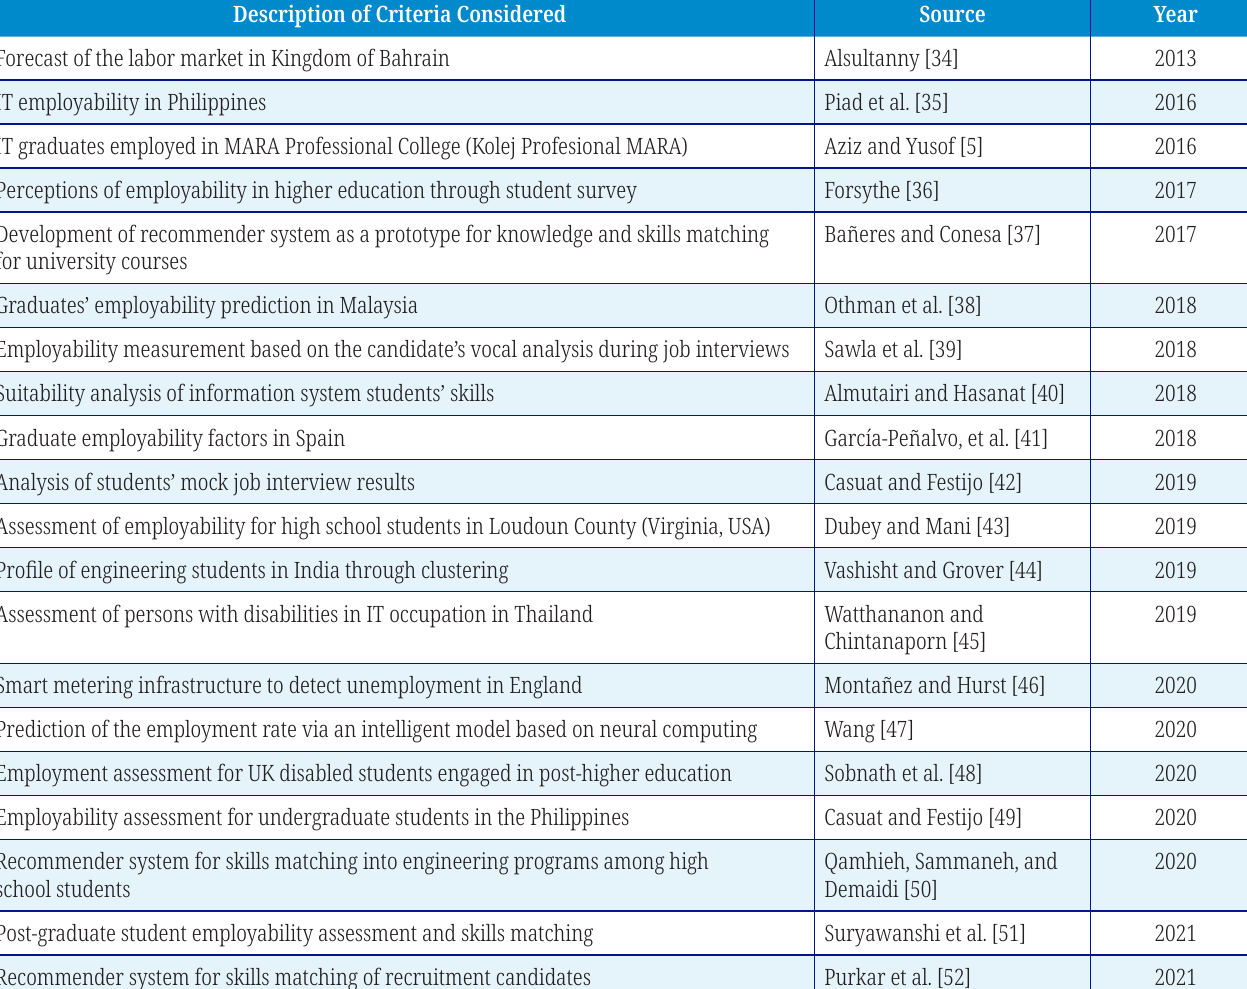
Table 8. Criteria for employability